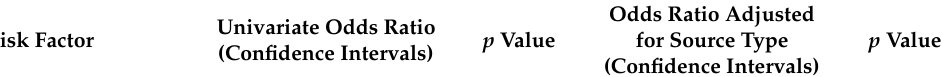
Table 2. Odds ratios for risk factors for high contamination ( > 150 CFU / 100 mL) of source water with E. coli based on logistic regression of 130 samples from 93 water